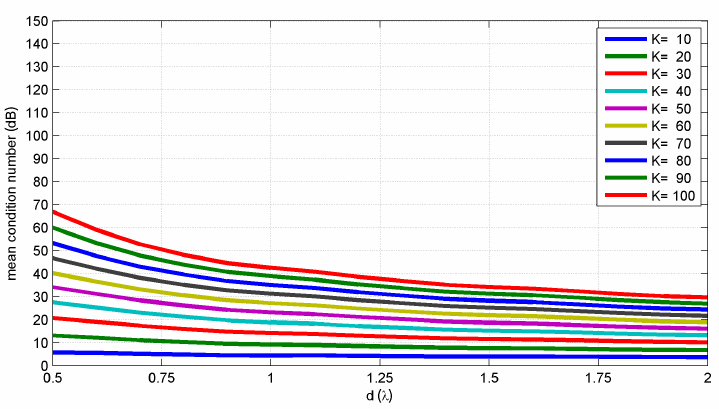
Figure 16. Mean condition number of the channel matrix as a function of the average inter-element distance d and the number of users K for a circular